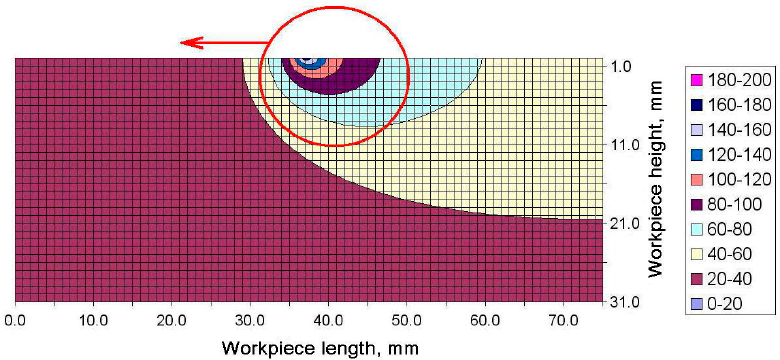
Figure 9. Temperature field registered for milling strategy 1 after Δ t = 5.2 s.